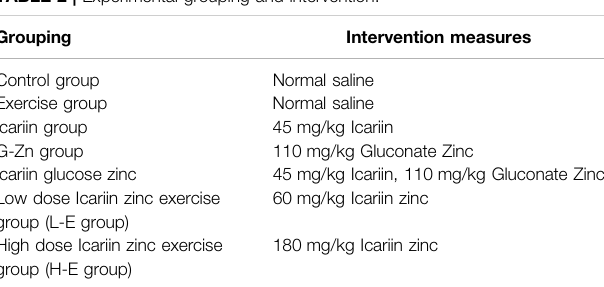
TABLE 2 | Experimental grouping and intervention.